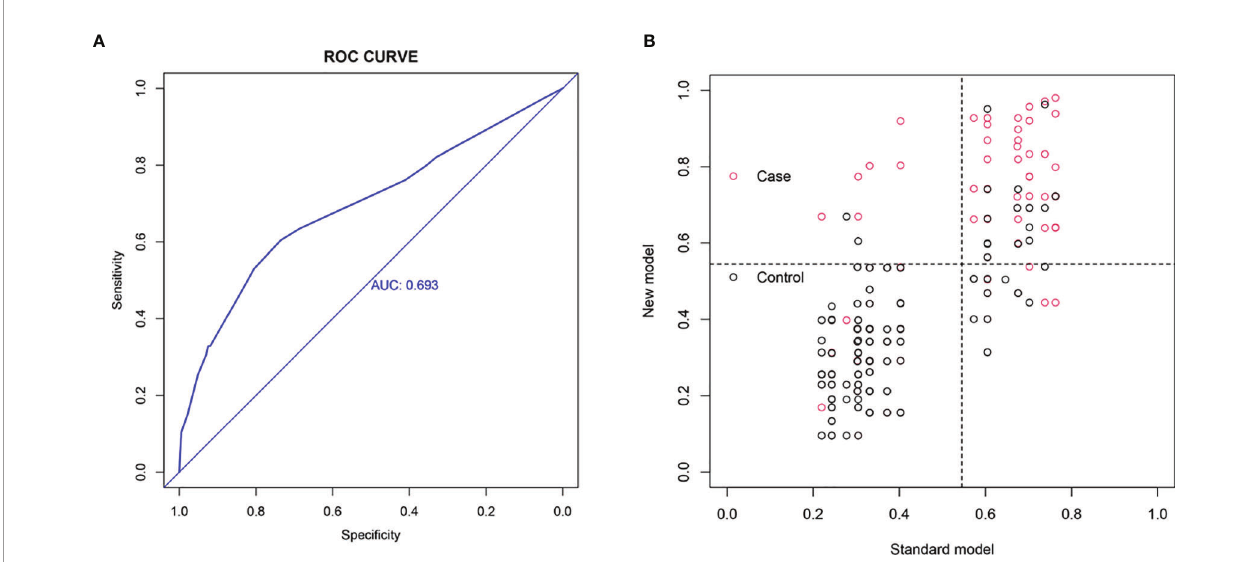
FIGURE 5 | Comparison with the original model. (A) ROC analysis. (B) Net reclassi fi cation index (NRI). NRI=0.04171037>0, (IDI=0.0902>0) indicates that the diagnostic performance of the new model is improved relative to the original